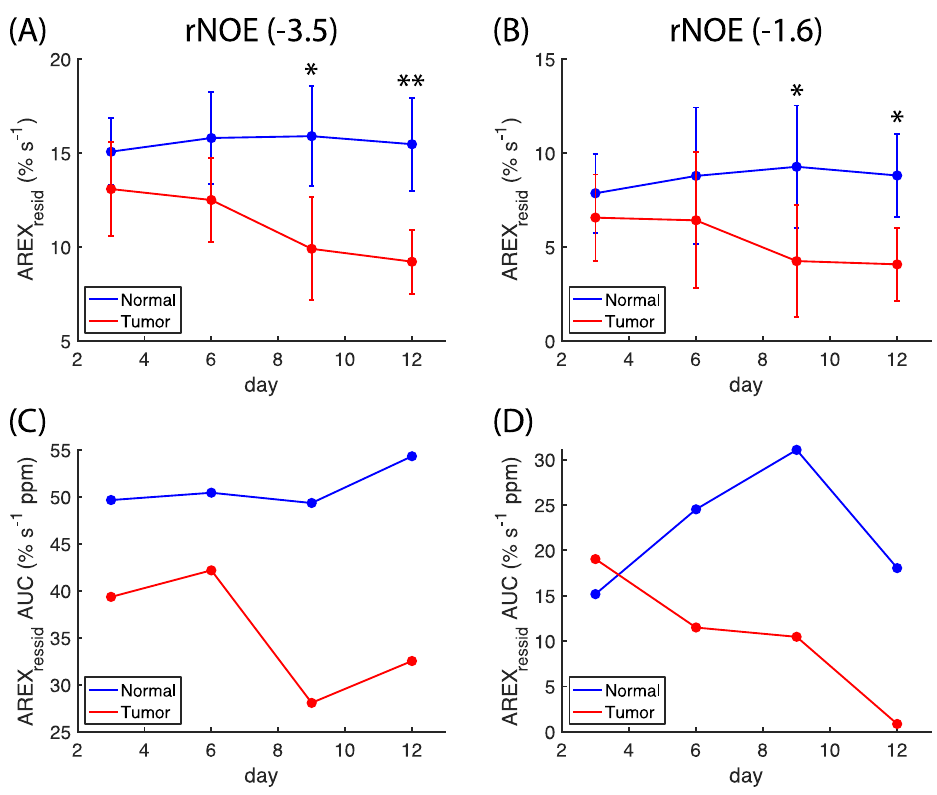
Figure 3. Longitudinal changes in magnitudes of AREX resid at − 3.5 ppm ( A ) and − 1.6 ppm ( B ), as extracted from Figure 2 (N = 9); longitudinal changes in area under the curve (AUC) of corresponding AREX resid at − 3.5 ppm ( C ) and − 1.6 ppm ( D ). (* p < 0.05, ** p < 0.001).